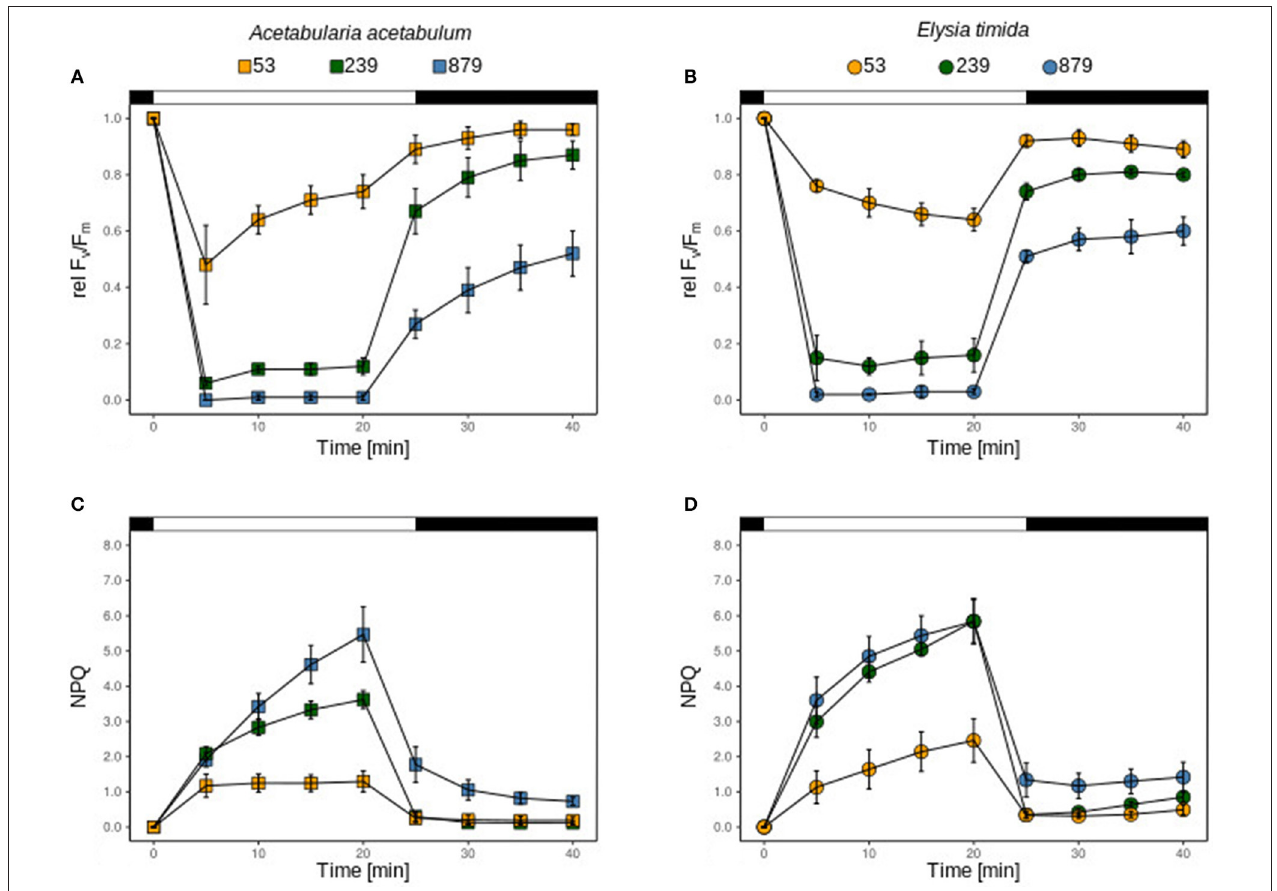
FIGURE 2 | relF v /F m and NPQ of chloroplasts of A. acetabulum (A,C) and kleptoplasts of freshly fed E. timida (B,D) under three different light intensities (53, 239, and 879 µ mol photons m − 2 s − 1 ). The bar represents the dark acclimation phase (first black part), the light exposure time (white part) and the recovery phase (second black part). All measurements were performed in biological triplicates and error bars show the standard